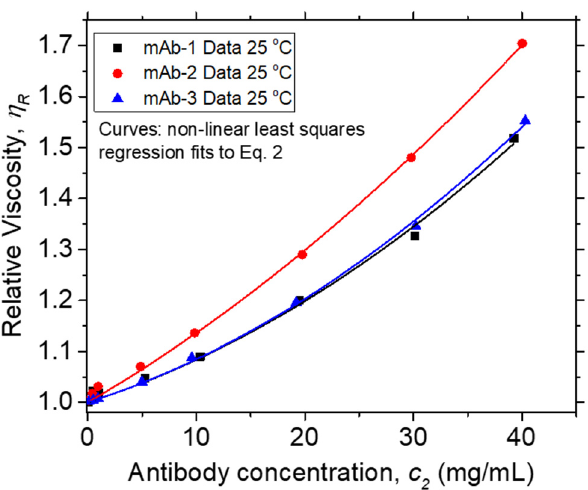
Figure 2. Viscosity η at 25 °C vs. mass concentration units ( c 2 ) of mAb formulations. Inset shows relative viscosity η R plotted vs. dimensionless concentration c 2 [ η ]. Bars on data points denote standard deviations. Note that mAb-2 buffer contains 5% ( w / v ) sucrose and 2.5% ( w / v ) sorbitol, resulting in higher η values than mAb-1 and mAb-3 buffers. For both mAb-1 and mAb-2, each data point was an average of n = 3 measurements, while for mAb-3, each data point was an average of n = 5 measurements.